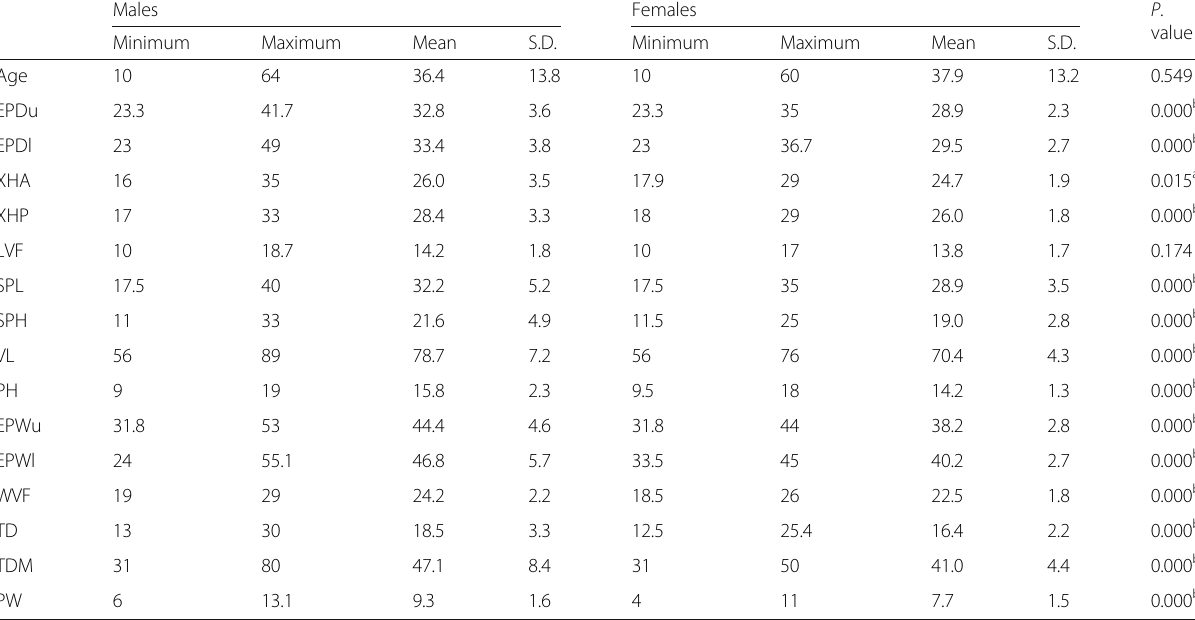
Table 2 Male and female difference in measurements of L1 Males